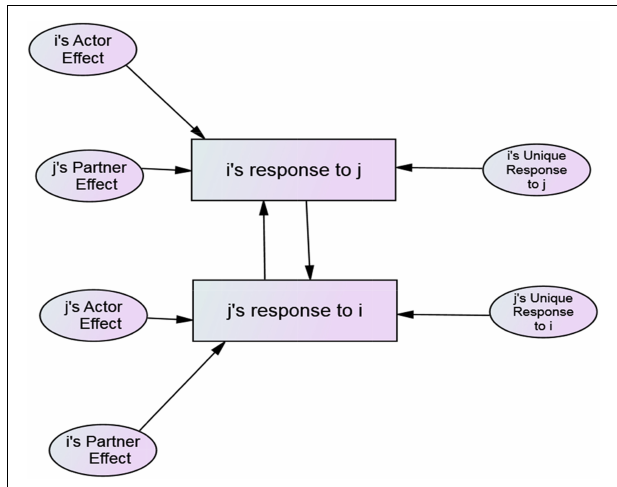
FIGURE 1 | A conceptual representation of the SRM at the individual and dyadic